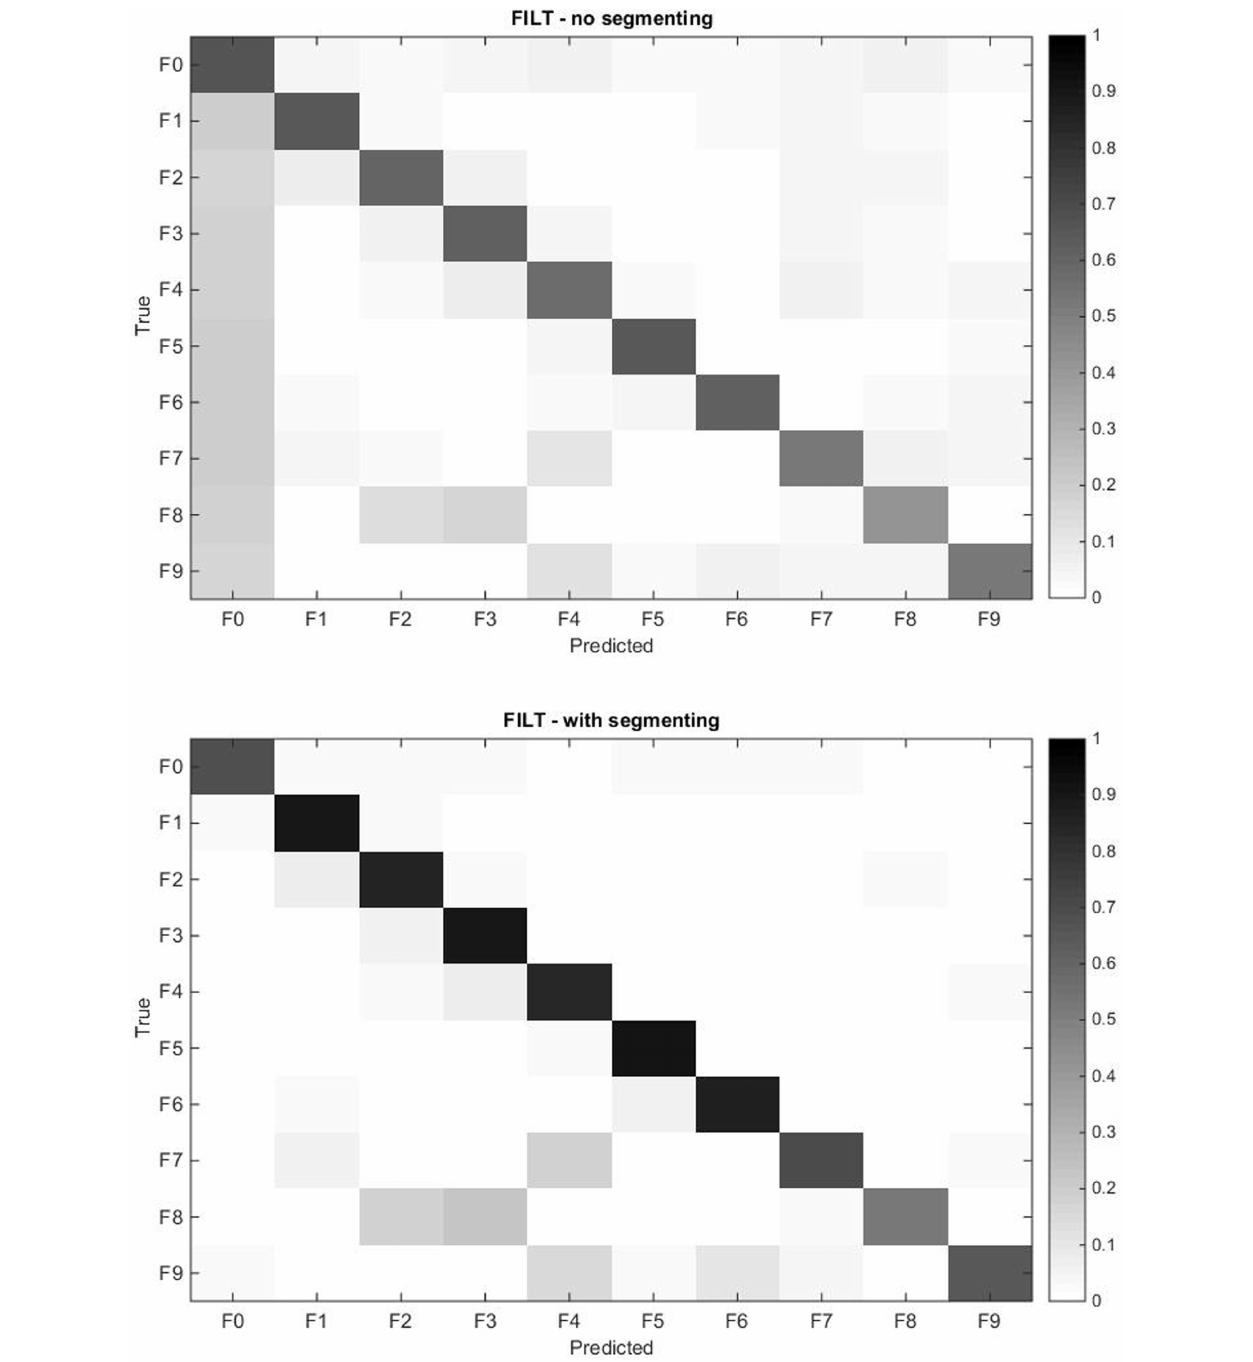
FIGURE 9 | Confusion matrix for the models obtained with the FILT FE averaged over all 40 subjects for all force patterns including rest. The rows represent the true class, and each cell corresponds to the prediction accuracy of each class. The top plot corresponds to the continuous data, while the bottom plot corresponds to the segmented